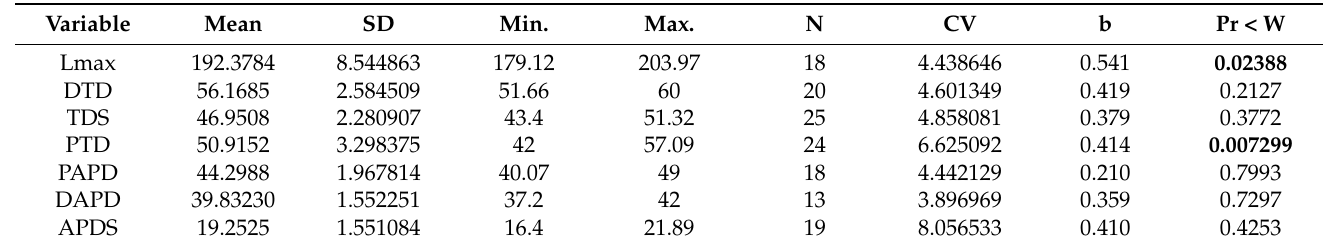
Abbreviations as in Table 1. Variables that exceed the threshold are in bold. Table 6. Sex-combined statistics for third metacarpal variables.